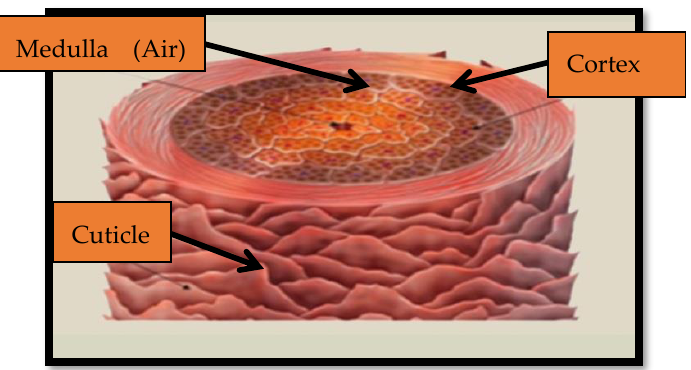
Figure 12. Parts of hair fiber [37]. Table 9. Amino acids present in normal human hair [96].